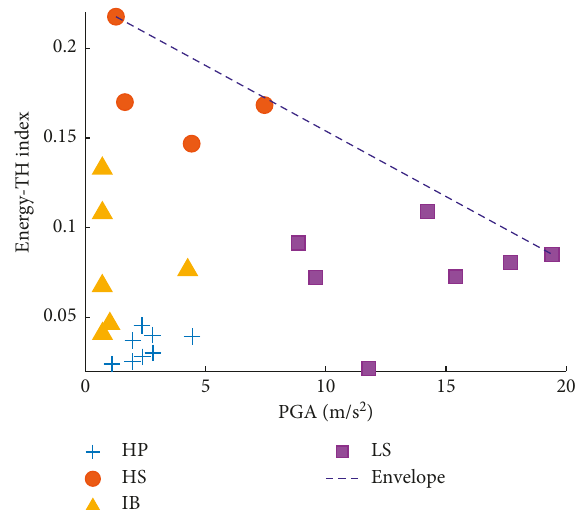
Figure 28: Energy-TH index of test cases under acceleration excitation. Table 7: Energy-TH index of each case and frequency range of each test